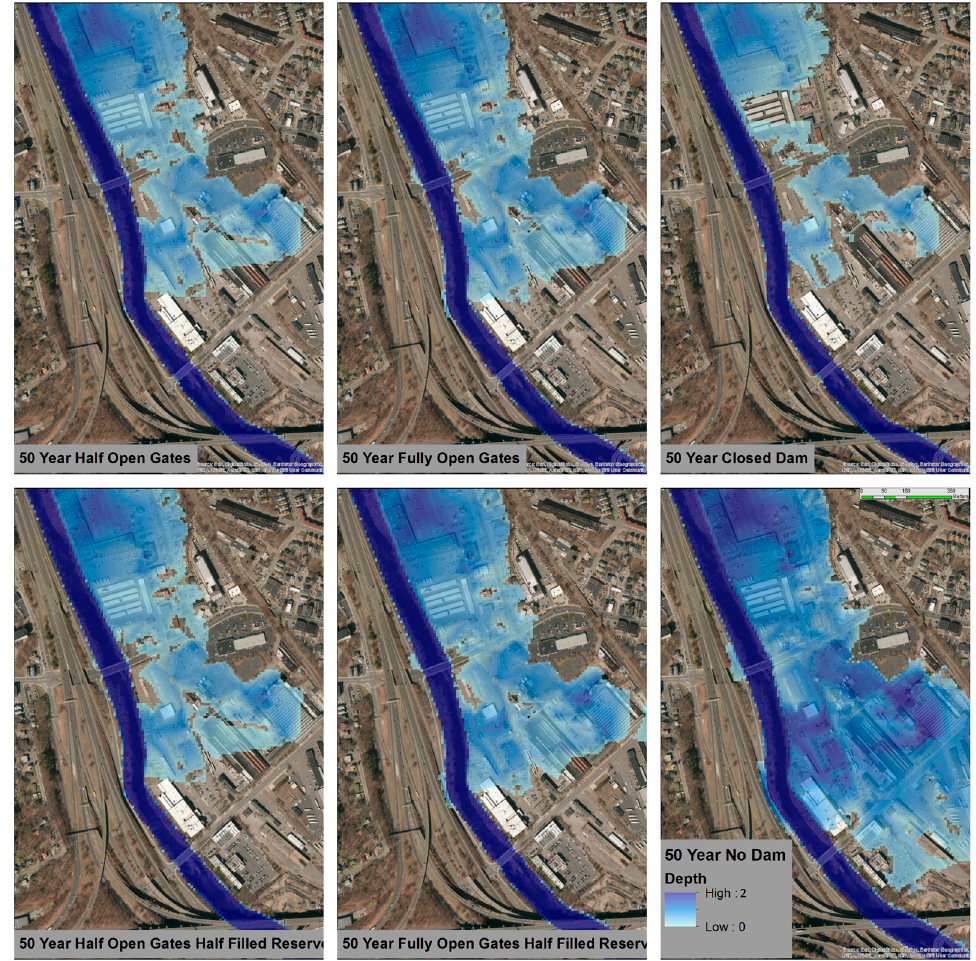
Figure 8. Simulated maximum 50-year flood inundation in various dam operation scenarios.